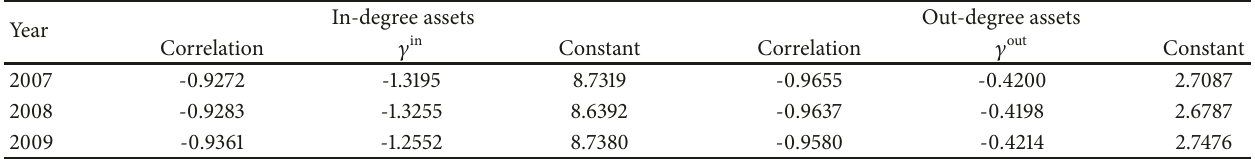
Figure 6: Decision behavior of listed company 2 when its Market Capitalization decreases. Table 2: Correlation coefficients and the coefficients of linear fit in log–log